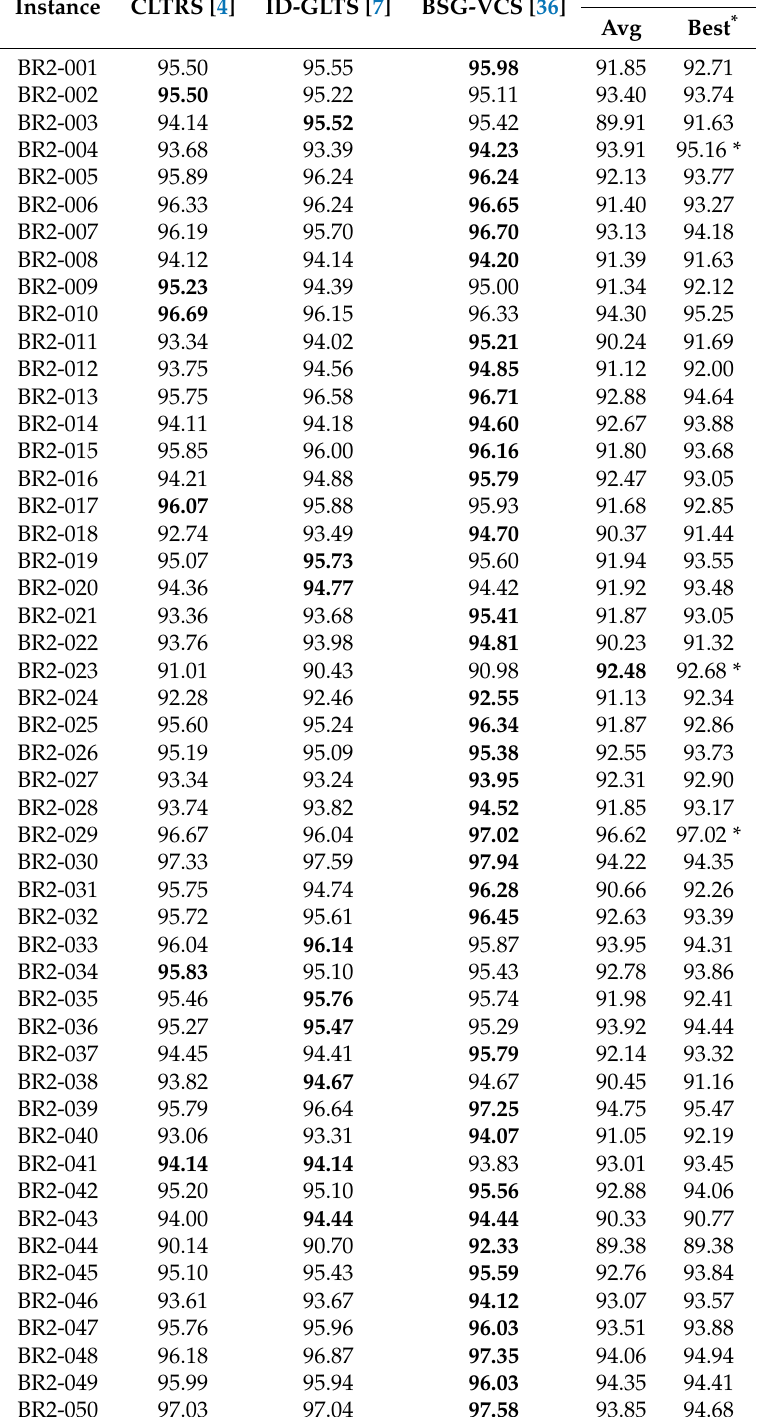
Table 3. Results for group